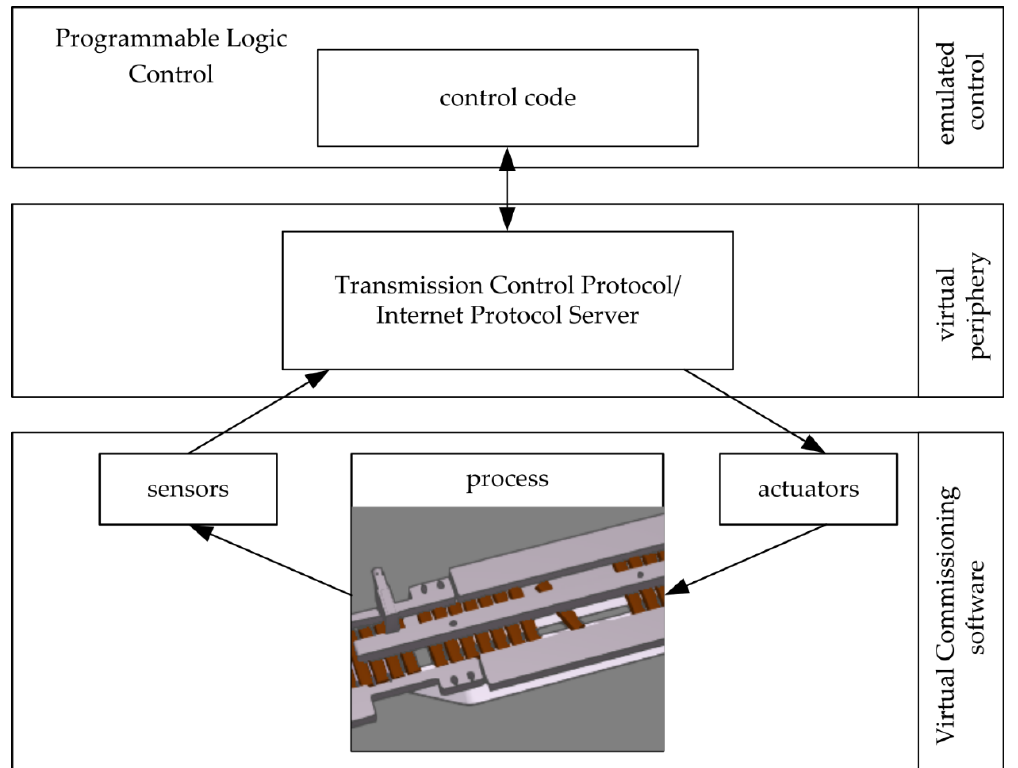
Figure 2. Structure of the virtual commissioning test configuration based on [19].